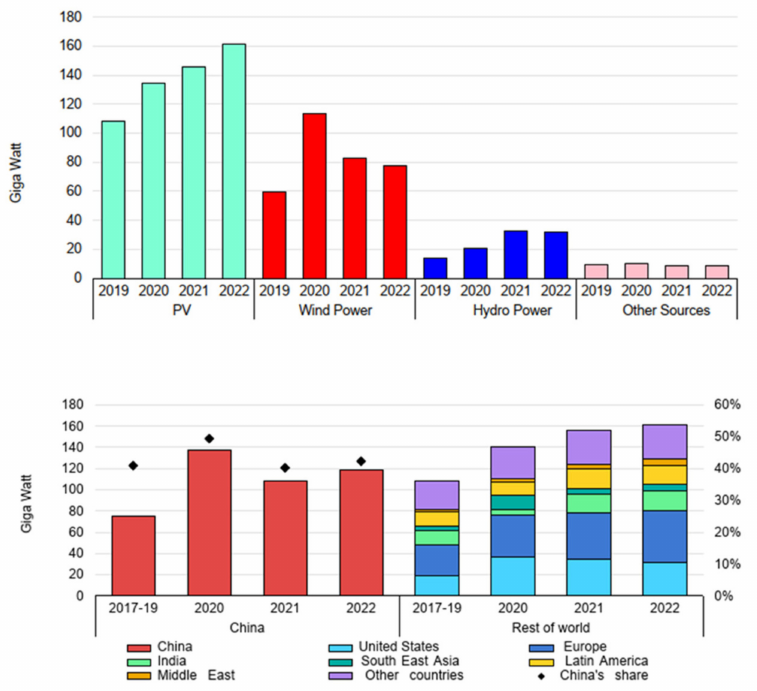
Figure 1. Renewable energy capacity data by technology and region based on Reference